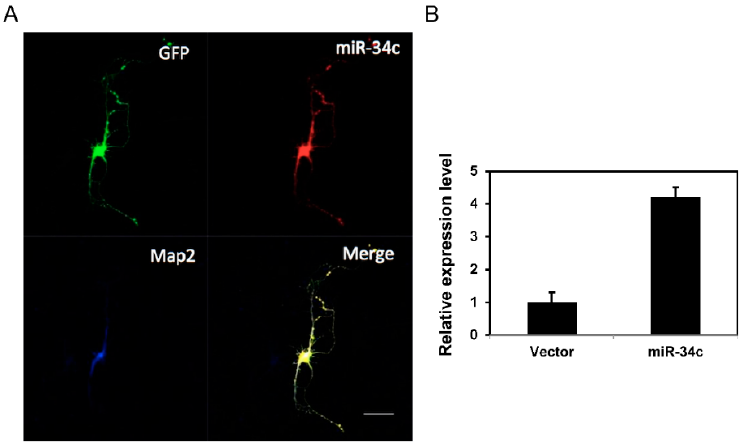
Figure 2. We observed that miR-34c was expressed in cultured hippocampal neurons. ( A ) Transfection of miR-34c was identified on DIV7 through immunofluorescence staining. Cells co-expressing green fluorescence (from GFP +/ − mice) and red fluorescence (from miR-34c-transfected cells) were selected, and neural dendrites were confirmed using the Map2 antibody. Scale bar = 50 μ m; ( B ) The expression level of miR-34c in the cultured hippocampal cells transfected with the miR-34c construct or control vector were detected using RT-PCR and calculated using a two-tailed Student’s t -test.